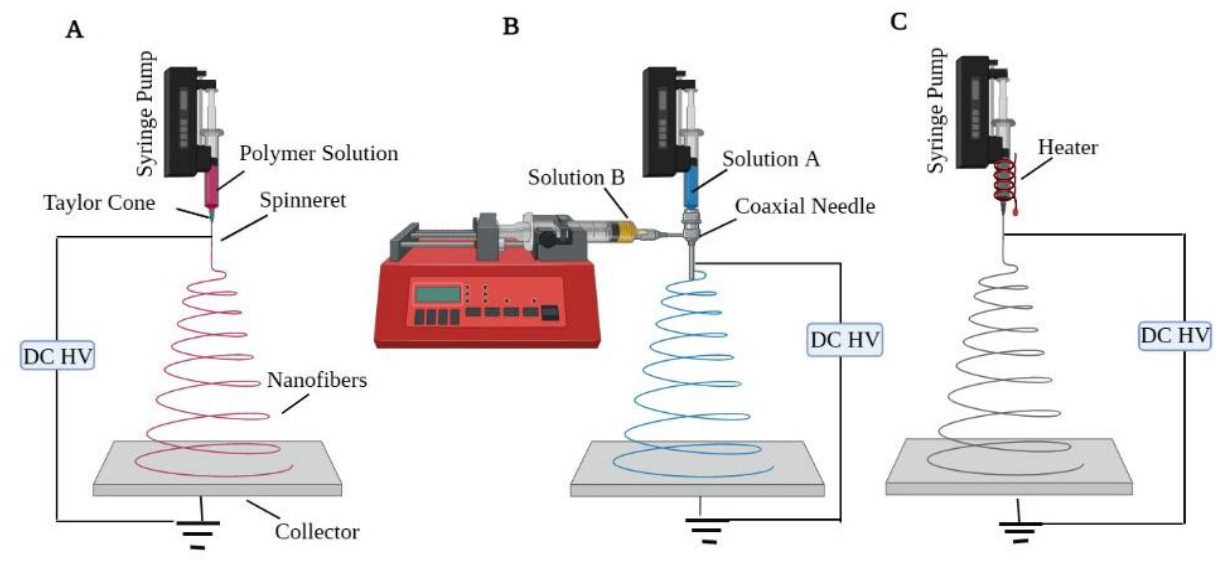
Figure 6. Schematic image of different electrospinning setups: ( A ) traditional electrospinning, ( B ) co-axial electrospinning, ( C ) melt electrospinning.